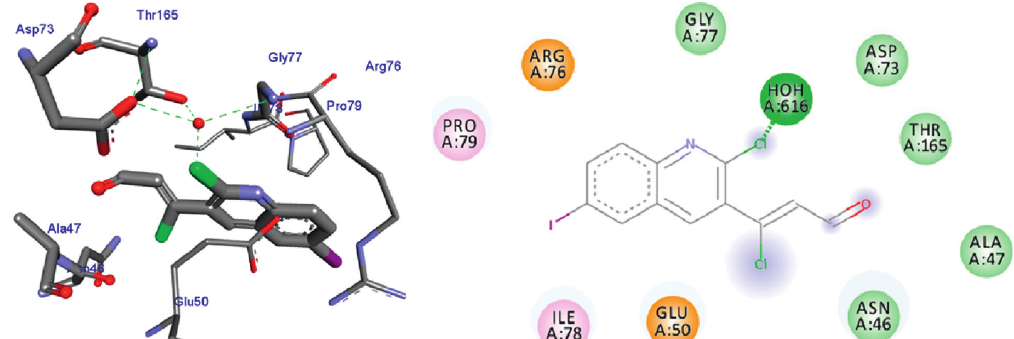
Figure 10: The binding interactions of 20 against E .coli DNA gyrase A (PDB ID: 6F86) .